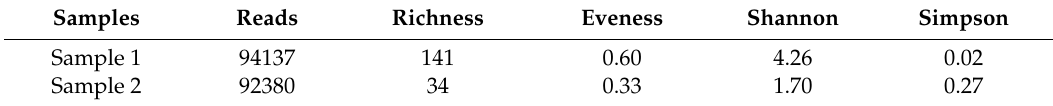
Figure 5. ( a ) Rarefaction curves for bacterial communities in sample 1 and sample 2; ( b ) Venn diagram drawn from number of amplicon sequences variants (ASVs) representative of sample 1 and sample 2. Table 2. Bacterial community richness and alpha-diversity indices.